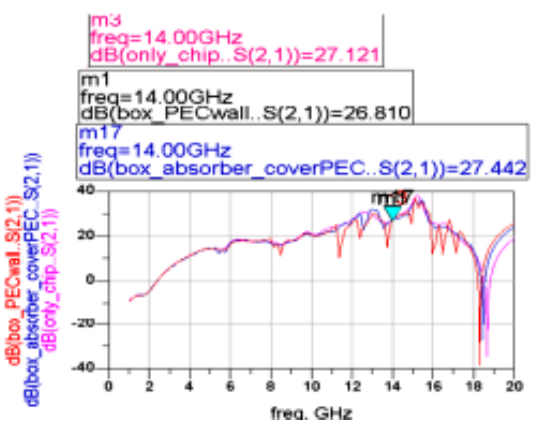
Figure 5: Red spikes seen as results of the Cavity resonance effect in the housed circuit; Blue spikes indicate that use of the absorber dilute the effect of cavity